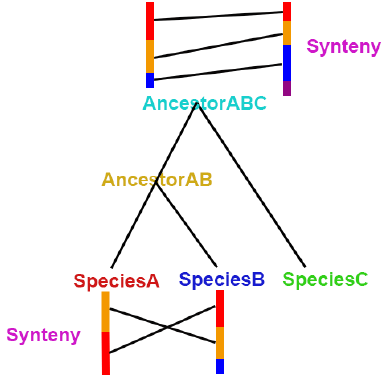
Figure 6. Example of a pattern diagram for inferring the chromosomes from ancestral genomes based on synteny analysis.